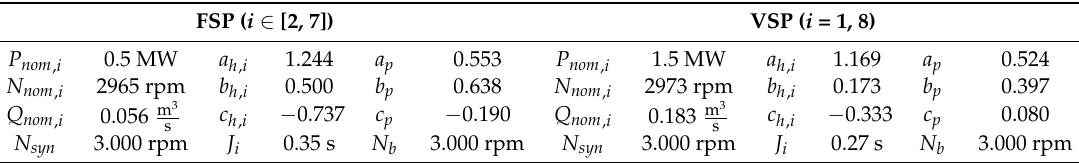
Table A3. Fixed-speed pump (FSP) and variable-speed pump (VSP) parameters.